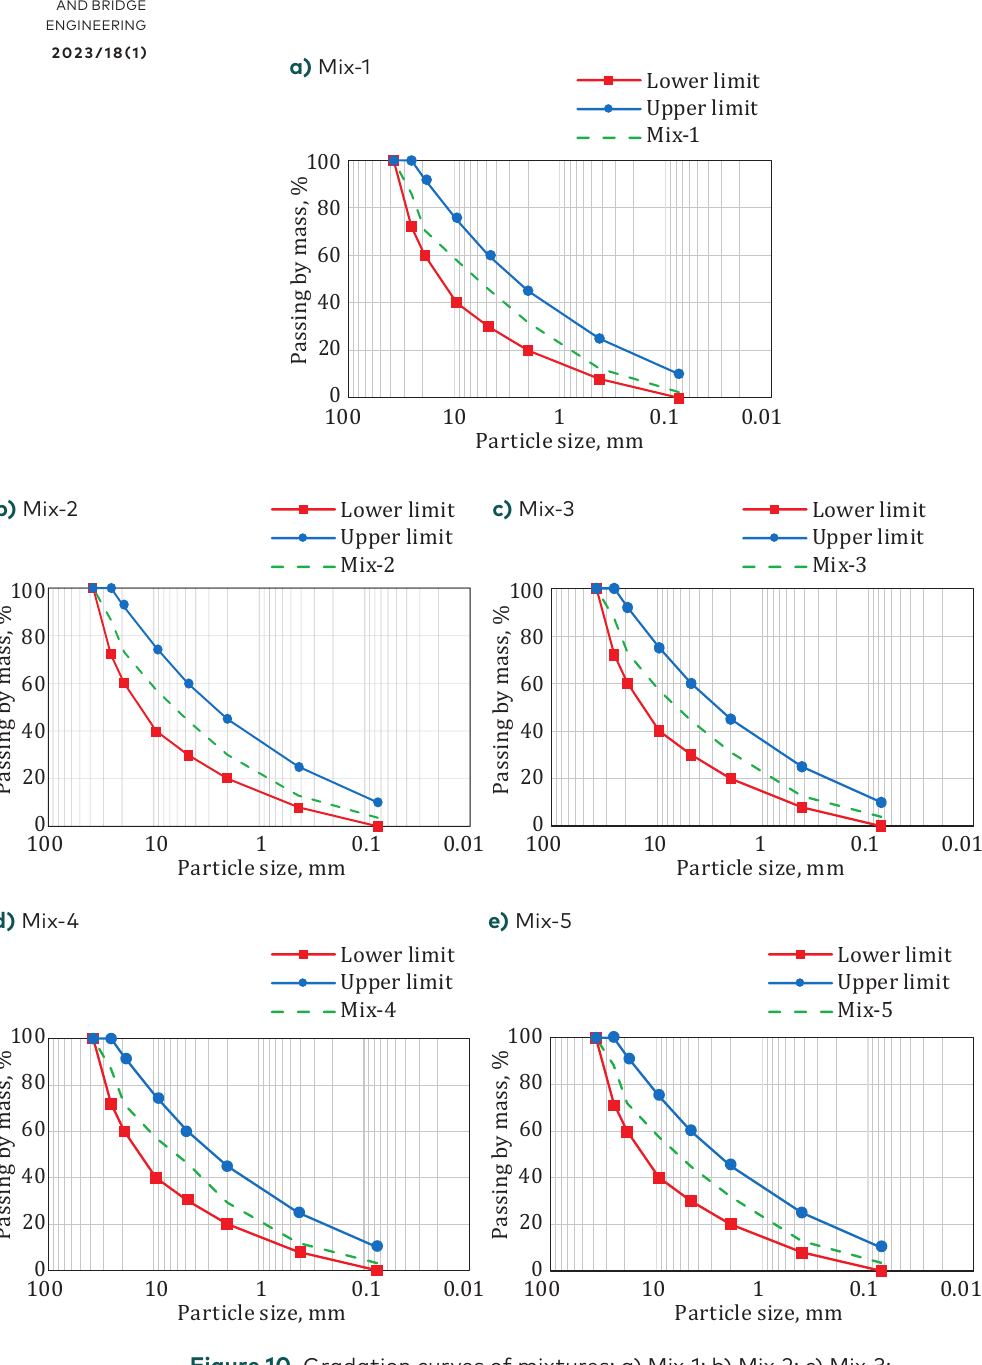
Figure 10. Gradation curves of mixtures: a) Mix-1; b) Mix-2; c)